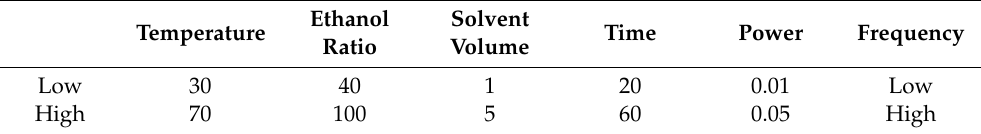
Table 4. The independent factors and their labels in uncoded form. Ethanol Solvent Temperature Time Power Ratio Volume